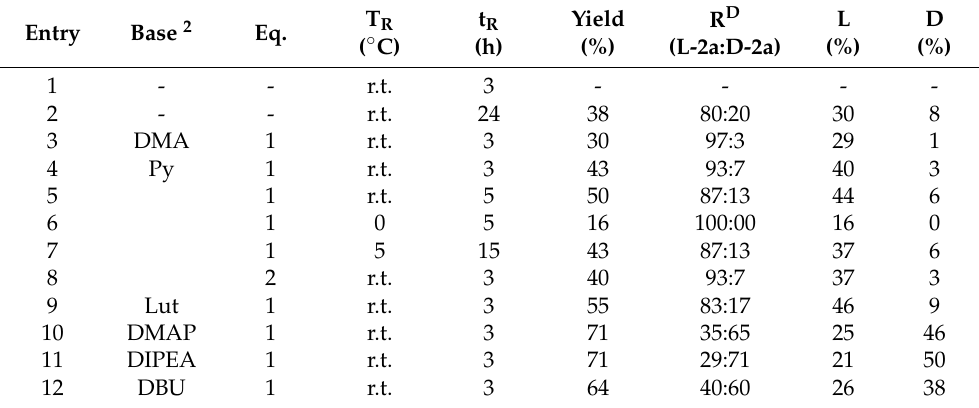
Table 4. Experimental parameters for the coupling of 1 with N -Ac- L -phe mediated by TBTU and different bases. Eq. = base equivalents, T R = reaction temperature, t R = reaction time, R D = diastereoisomeric ratio ( L-2a : D-2a ) 1